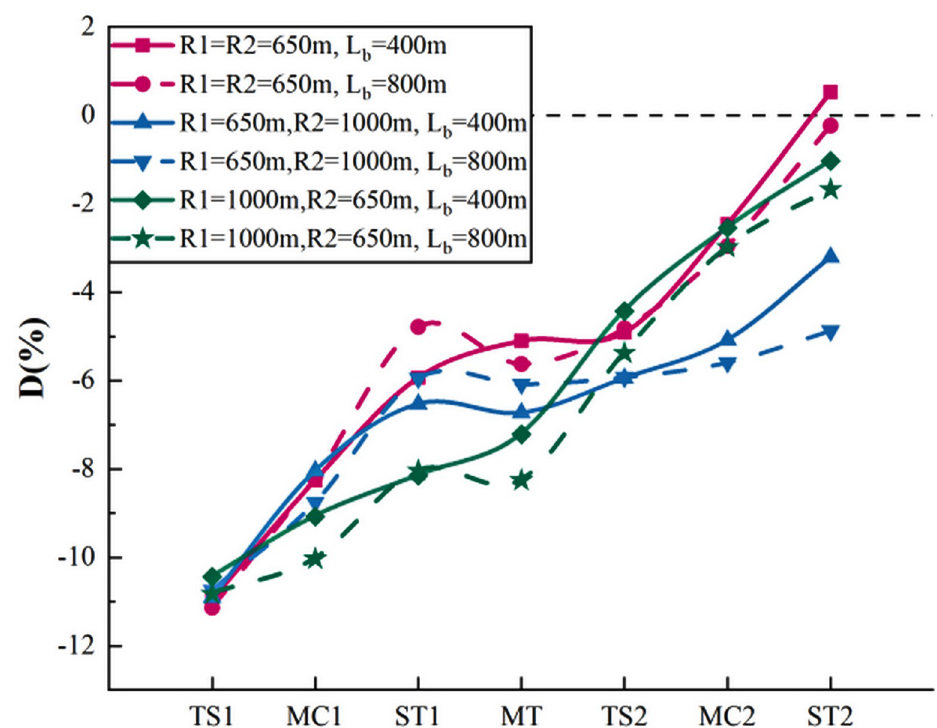
Fig 15. Perceived speed deviation diagram of adjacent curve in one direction.